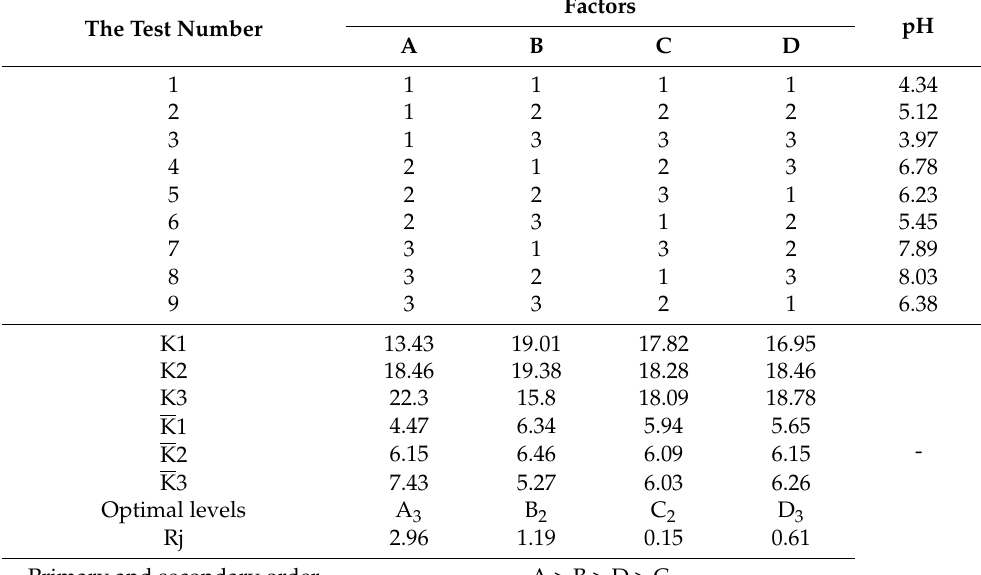
Table 3. Optimization of deacidification conditions.